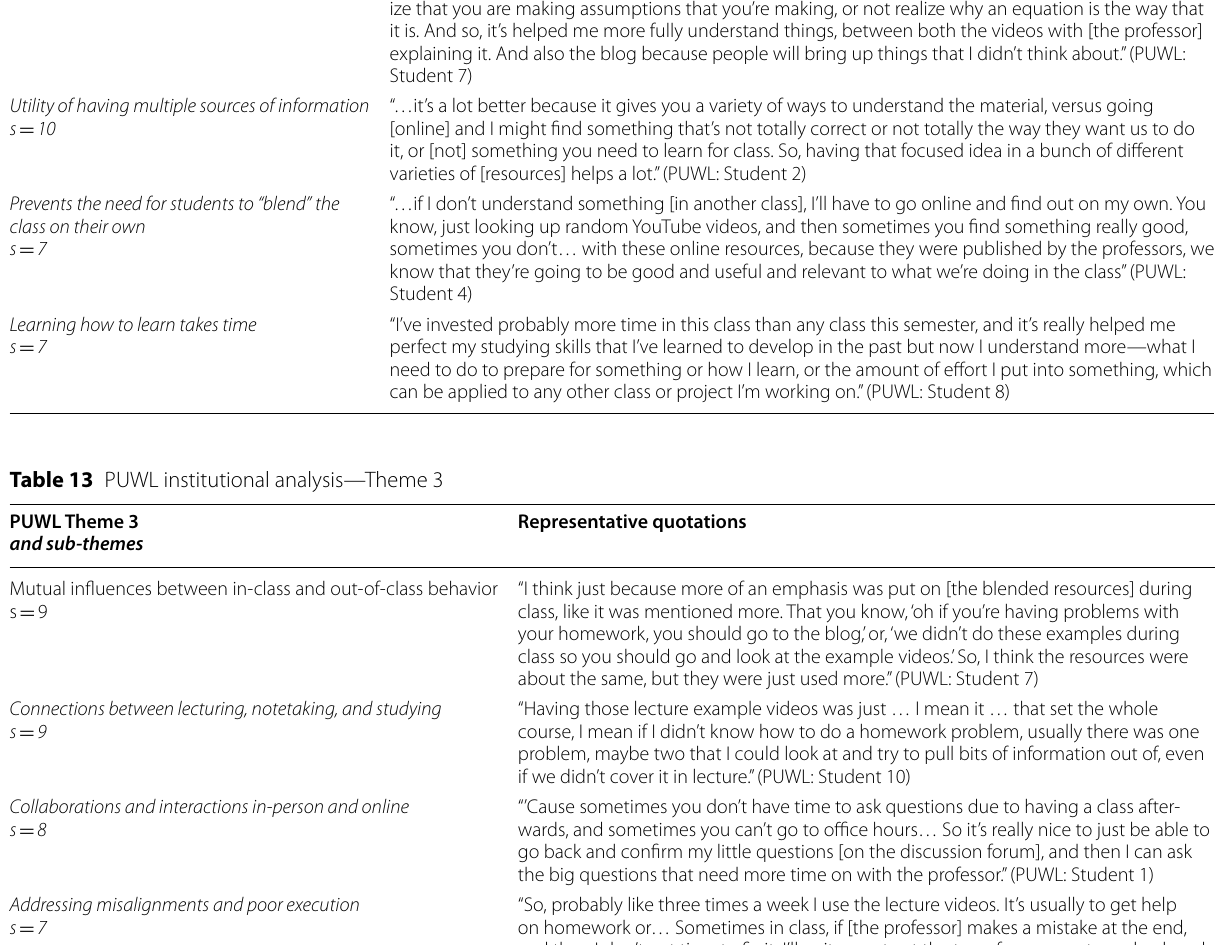
Table 12 PUWL institutional analysis—Theme 2 PUWL Theme 2 and sub-themes